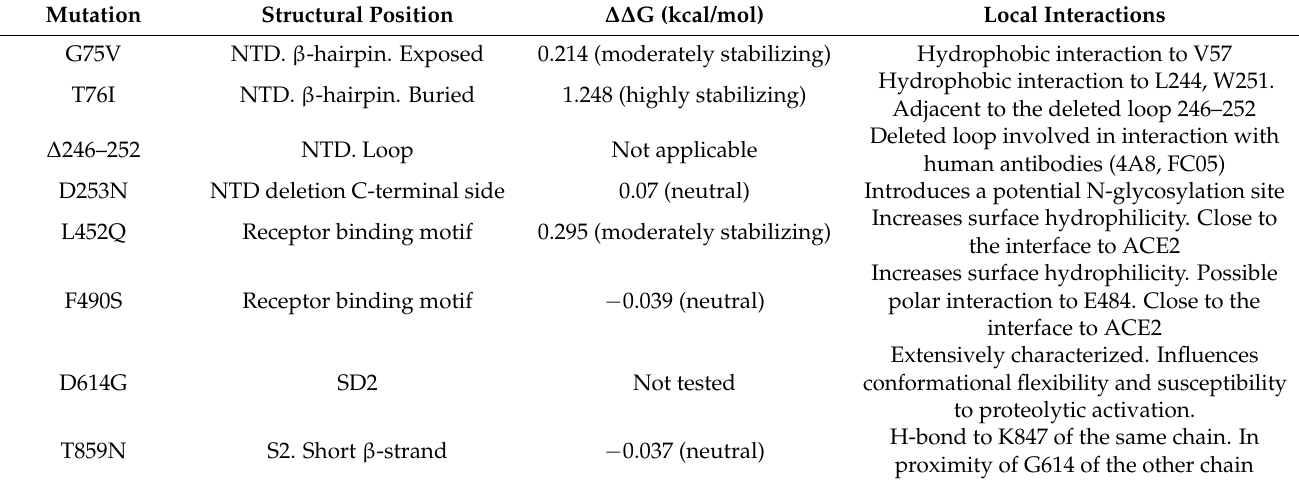
Table 1. Summary of analysis of Spike protein mutations by DynaMut. The differences in free energy were estimated in comparison to the Wuhan sequence. The program does not include deletion mutants.